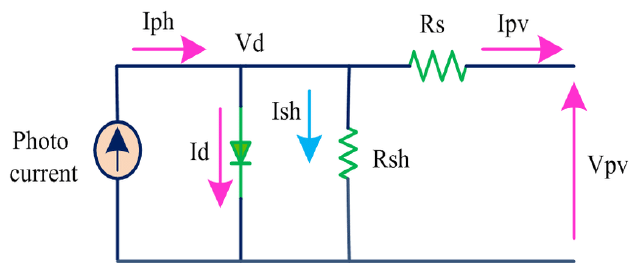
Fig. 1. Single diode